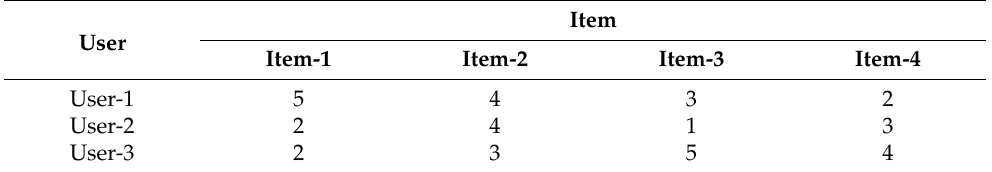
Table 1. The ratings of four items by three users.